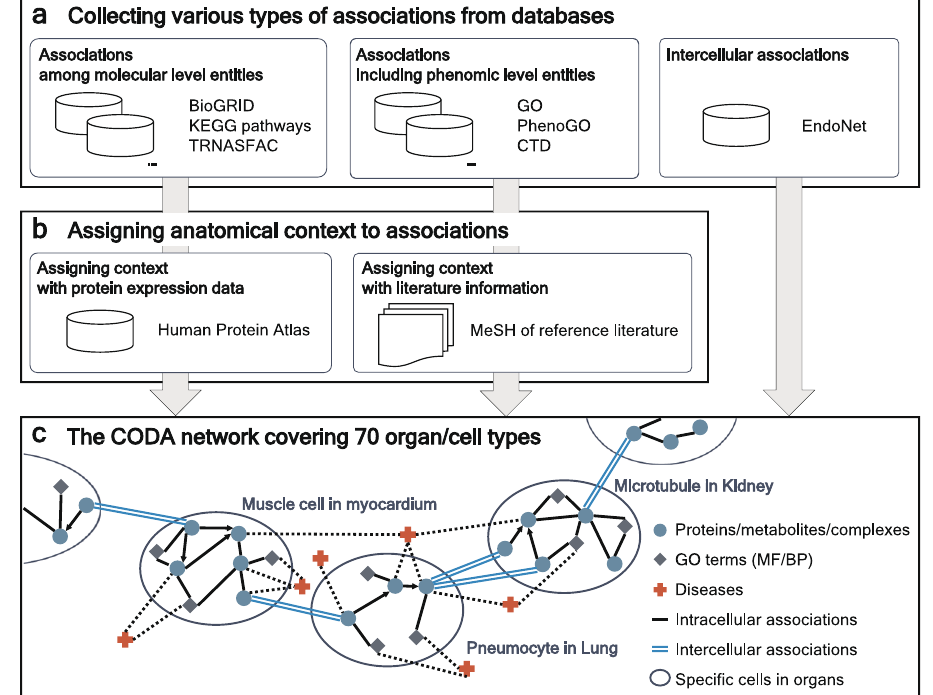
Figure 1. Overview of constructing the CODA network. ( a ) Associations including both molecular level entities and phenomic level entities are gathered from diverse databases, BioGRID, KEGG pathways, TRANSFAC, GO, PhenoGO, CTD, and EndoNet. All of the associations do not include anatomical contexts at first except for intercellular associations from EndoNet. ( b ) Anatomical contexts are assigned to associations among molecular level entities by using protein expression data from HPA. For associations including phenomic level entities, anatomical contexts are added to the associations using MeSH of their reference literature. Intercellular associations have anatomical context ab initio. ( c ) As a result, constructed CODA network consists of not only organ/cell type specific networks but also intercellular associations. Diverse associations among molecular level entities and phenomic level entities with anatomical context are contained in CODA